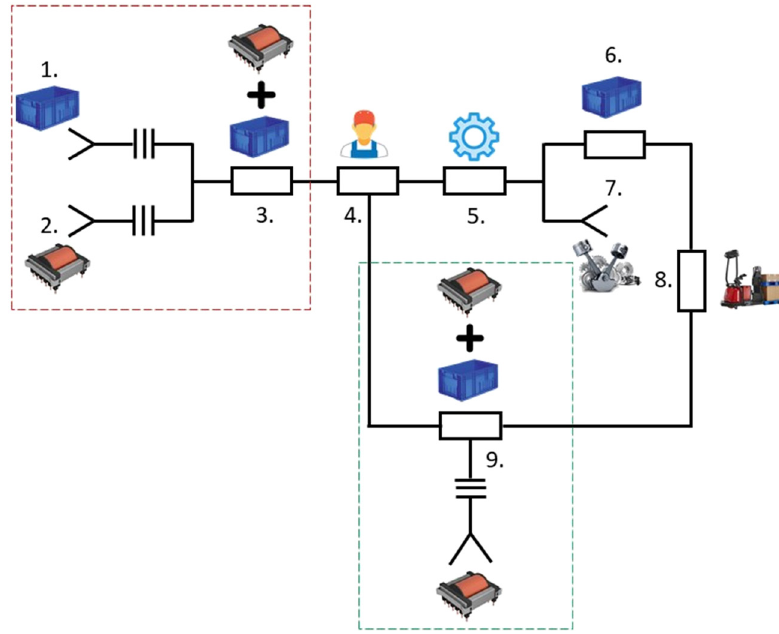
Figure 3: Block diagram of the two shuttle boxes mode when using a robotic